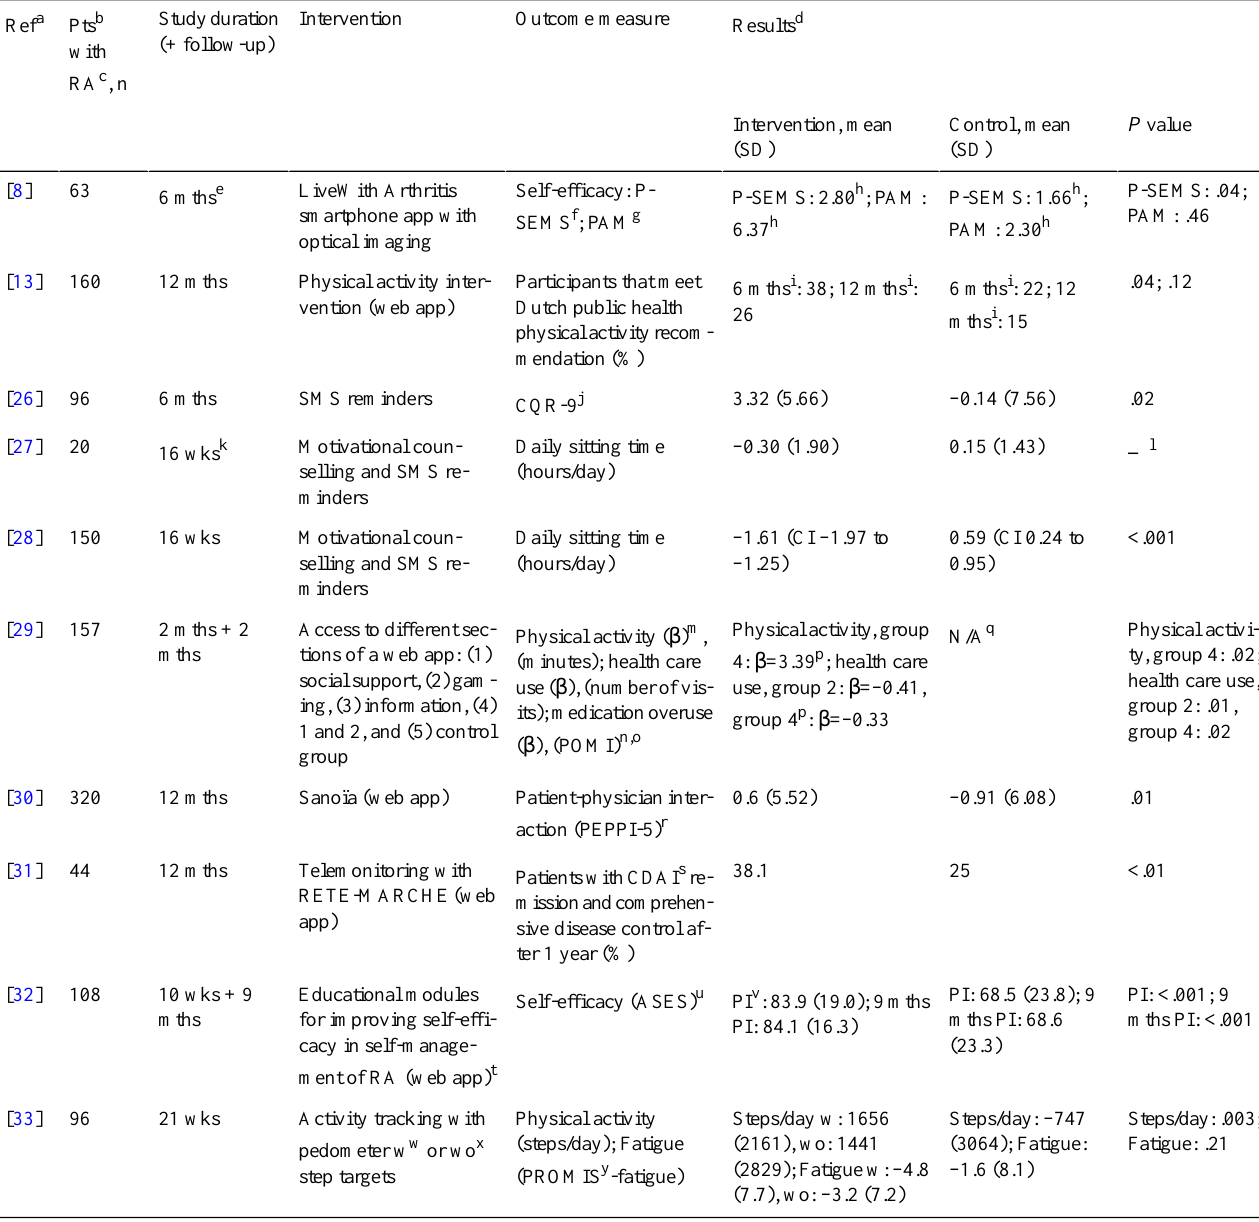
Table 1. Evidence for effectiveness of mobile health trials in patients with RA.